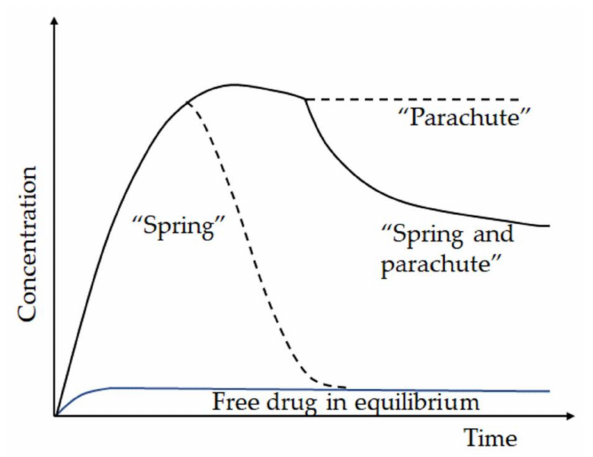
Figure 7. Schematic representation of API dissolution illustrating the “spring and parachute”